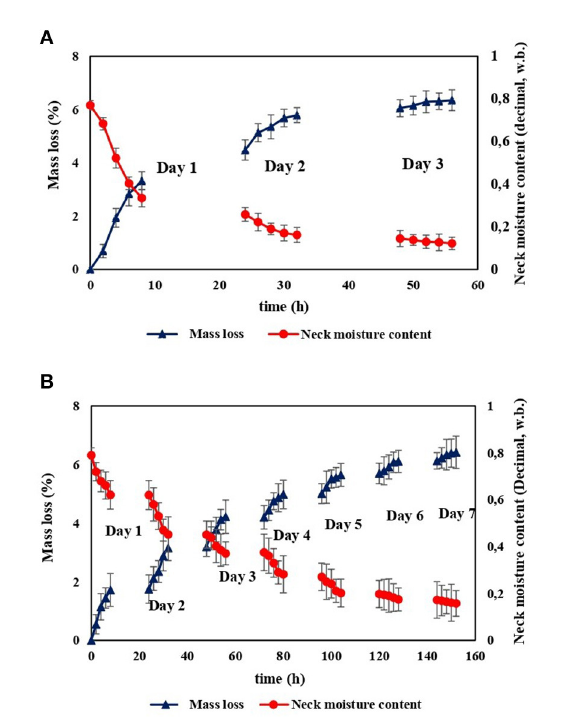
FIGURE12 Measured mass loss and neck moisture content of onion bulb as a function of curing time cured: (A) using a solar dryer for a total duration of 3 days, (B) using field curing method for a total duration of 7 days (error bars are standard error, n =